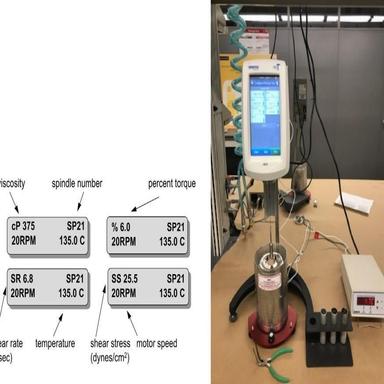
Superpave RV device and typical display details.